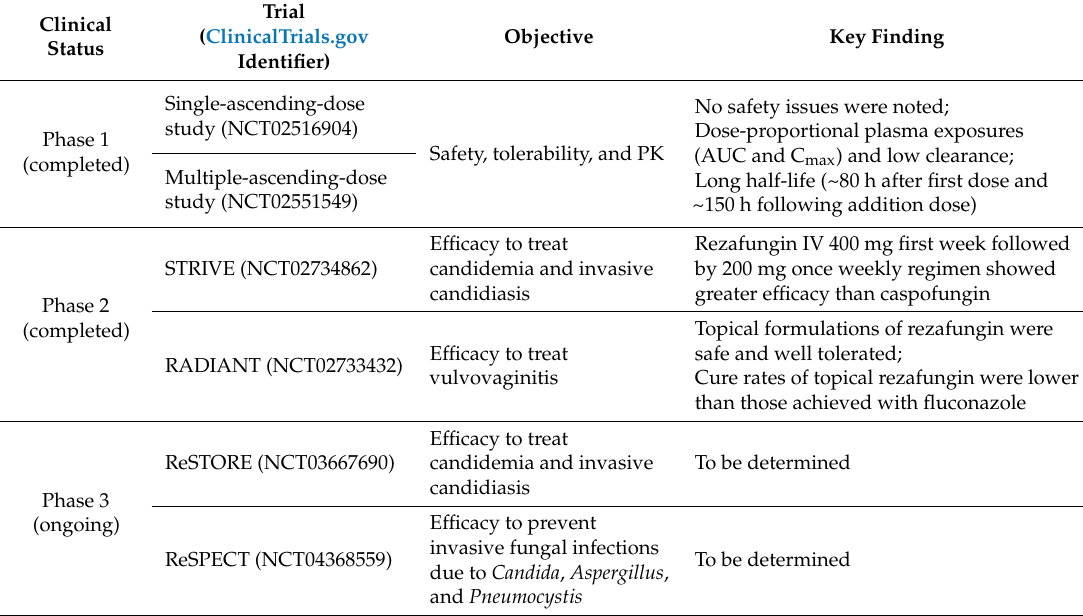
Table 2. Summary clinical evaluation of